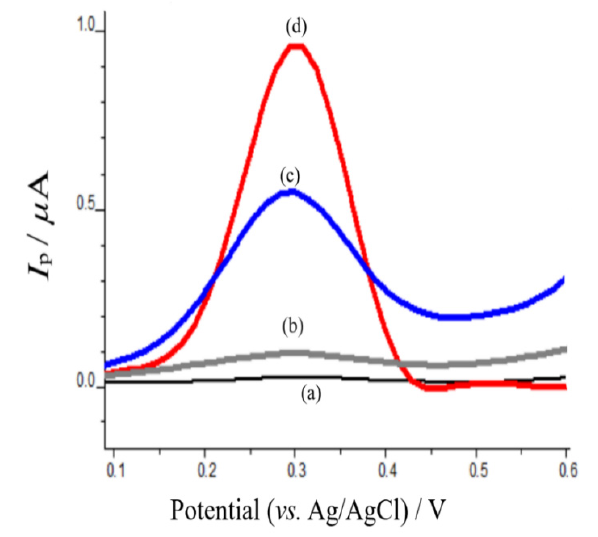
Figure 6. Anodic adsorptive square wave stripping voltammograms of ( a ) CPE, ( b ) 0.04 mg L − 1 mephedrone on CPE and ( c ) 40.00 mg L − 1 poly-AgNPs@Sa-CPE, and ( d ) 146.0 mg L − 1 mephedrone on poly-AgNPs@Sa-CPE in acetate buffer pH 4.0 containing 0.05 mol L − 1 KF. Other experimental conditions as described in the material and methods section.